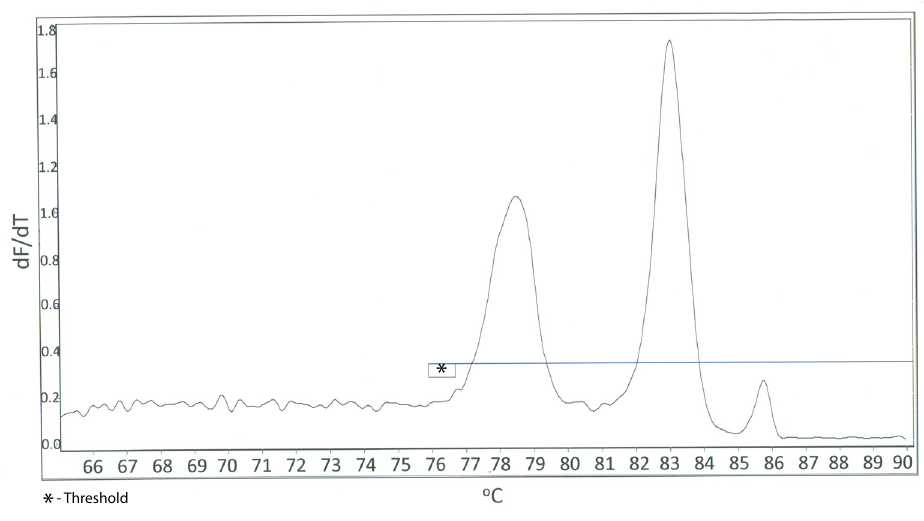
Figure S1. DNA products observed for MMP10 Singleplex HRM Assay. High resolution derivative melt curve plot for a DNA sample for the MMP10 singleplex HRM assay. The presence of two products (78.5 and 83.1°C) was observed. The x-axis represents temperature (°C) and the y-axis represents the first derivative of the change of fluorescence with temperature (-dF/dT). The horizontal line on each plot represents the analysis